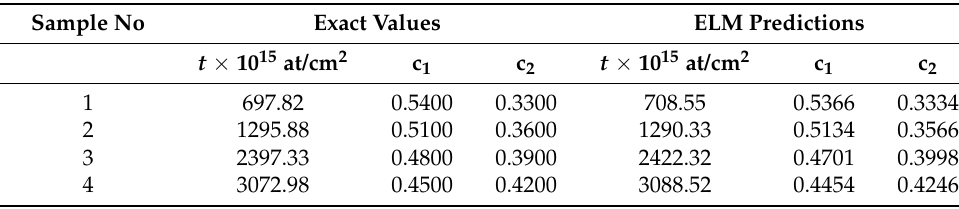
Table 2. Multilayer perceptron (MLP) predicted results and exact